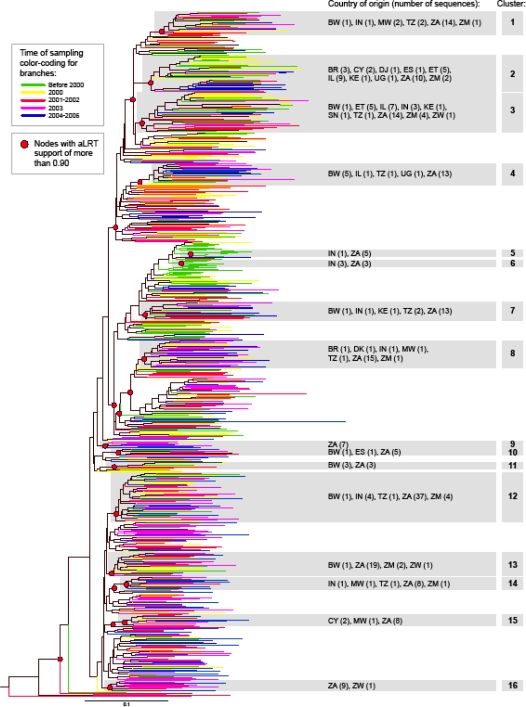
Phylogenetic relationships between HIV-1 subtype C gag sequences. Phylogenetic tree was constructed by PhyML. Color branches represent year of sampling by group. Nodes with significant aLRT support are highlighted.